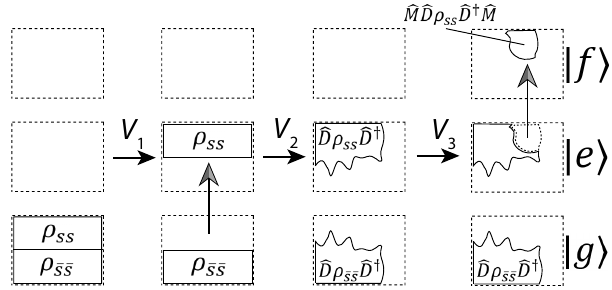
FIG. 9. The general protocol of subspace tomography. The occupied areas of the rectangles loosely depict nonzero regions of the cavity density matrices, where ρ ss and ρ ¯ s ¯ s are blocks of the total-storage density matrix ρ . There are coherence elements between these two blocks that are not depicted because they do not impact the experiment at hand. The goal here is to isolate ˆ D † ˆ M in the | f (cid:2) subspace using the operations V ˆ M ˆ D ρ ss V 3 , as shown in the image.